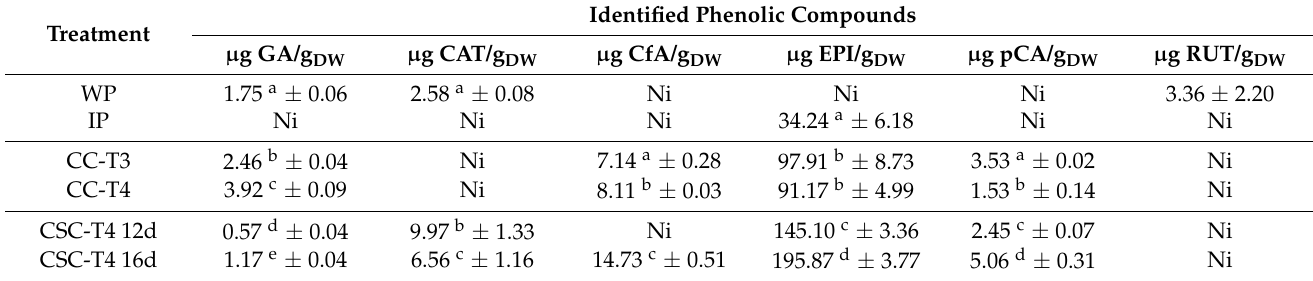
Gallic acid (GA), catechin (CAT), caffeic acid (CfA), epicatechin (EPI), p-coumaric acid (pCA), rutin (RUT). Ni = Not identified. Different letters in the same column mean significant differences between treatments ( p <